Question: Does the plotted quantity increase or decrease?
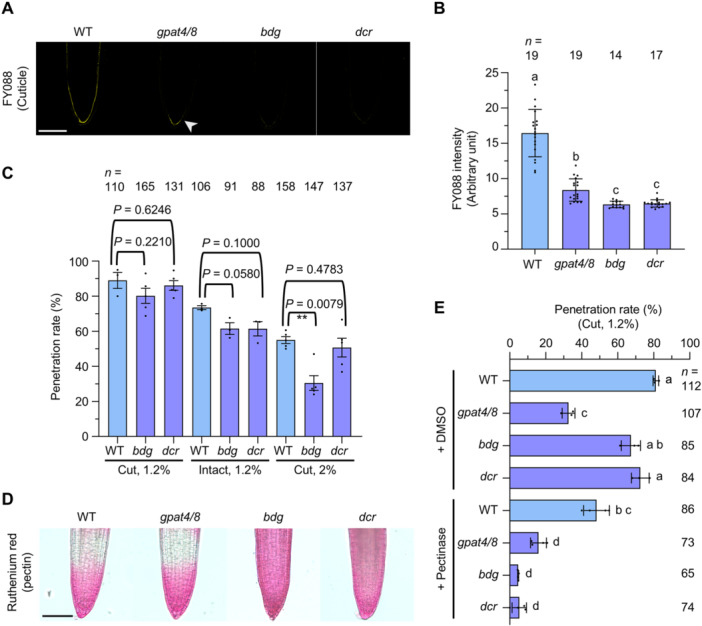
Answer: increasing